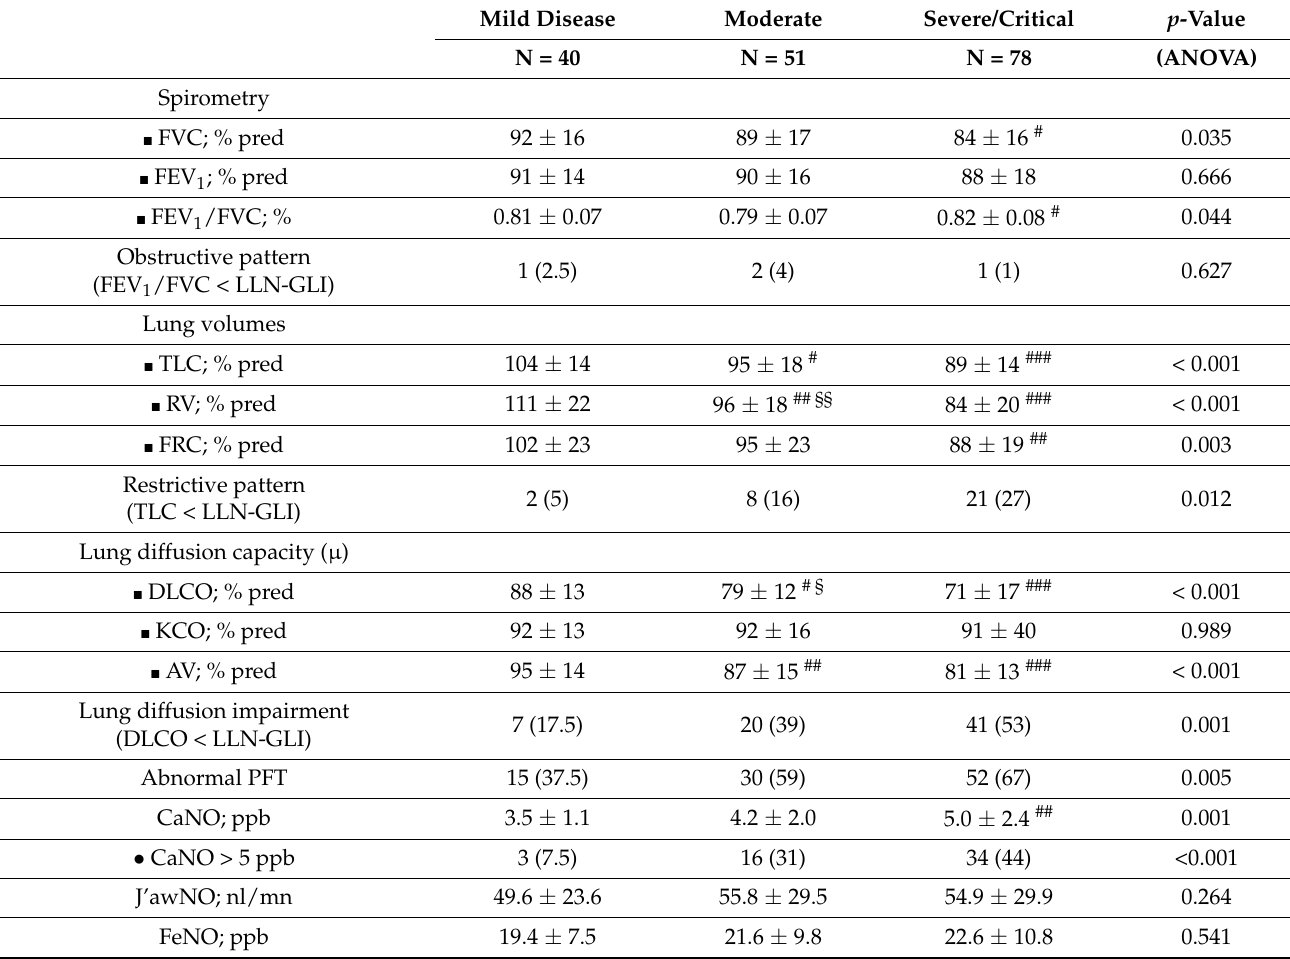
Table 2. Pulmonary function tests and exhaled nitric oxide measurement in patients with recovered SARS-CoV-2 pneumonia. Mild Disease Moderate Severe/Critical p -Value N = 40 N = 51 N = 78 (ANOVA)